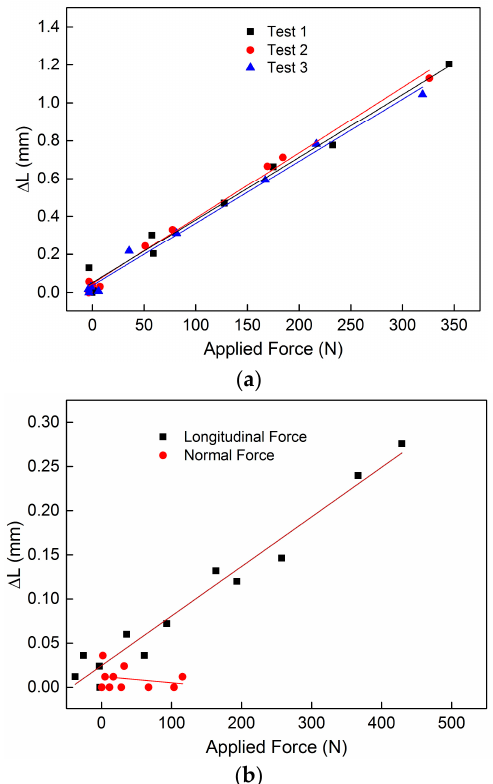
Figure 7. Response of the 1D FCS sample ( a ) to applied force as well as the response of the 2D FCS to applied longitudinal and normal forces ( b ). applied longitudinal and normal forces ( b